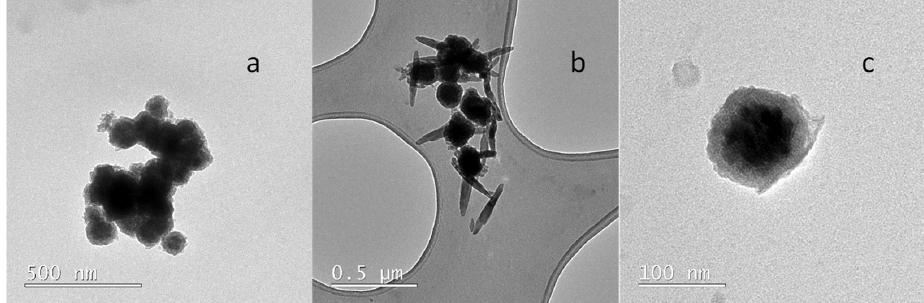
Figure 2. Transmission electron microscopy micrographs of the synthesis methods used on Fe3O4@SiO 2 : ( a ) Method A; ( b ) Method B; ( c ) Method C.